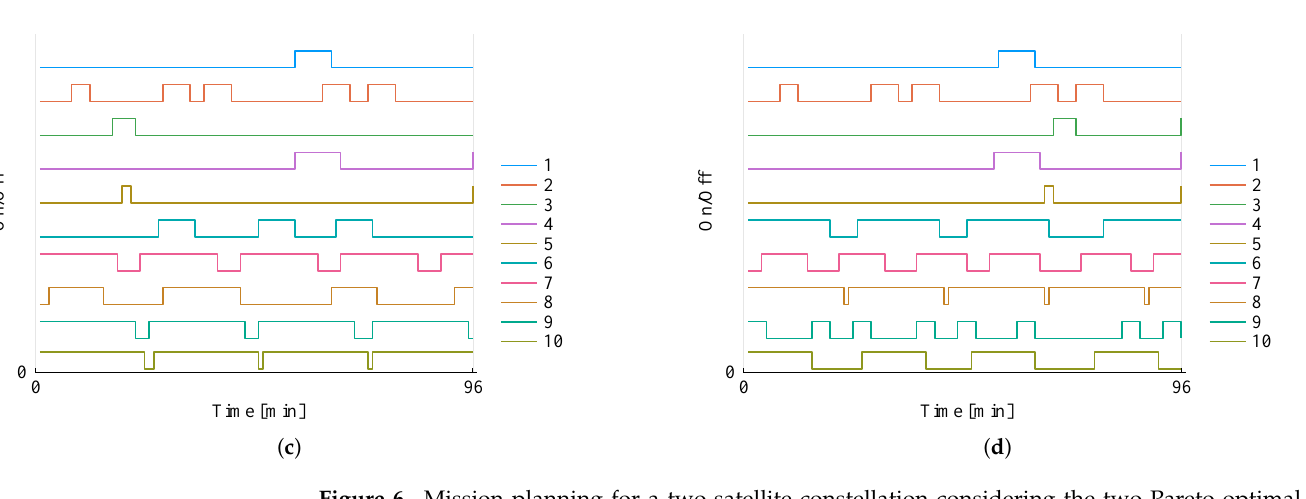
Figure 6. Mission planning for a two-satellite constellation considering the two Pareto-optimal extreme points: maximizing A (tasks 1 to 5) and maximizing B (tasks 6 to 10). ( a ) Scheduling for satellite 1, maximizing A. ( b ) Scheduling for satellite 2, maximizing A. ( c ) Scheduling for satellite 1, maximizing B. ( d ) Scheduling for satellite 2, maximizing B.